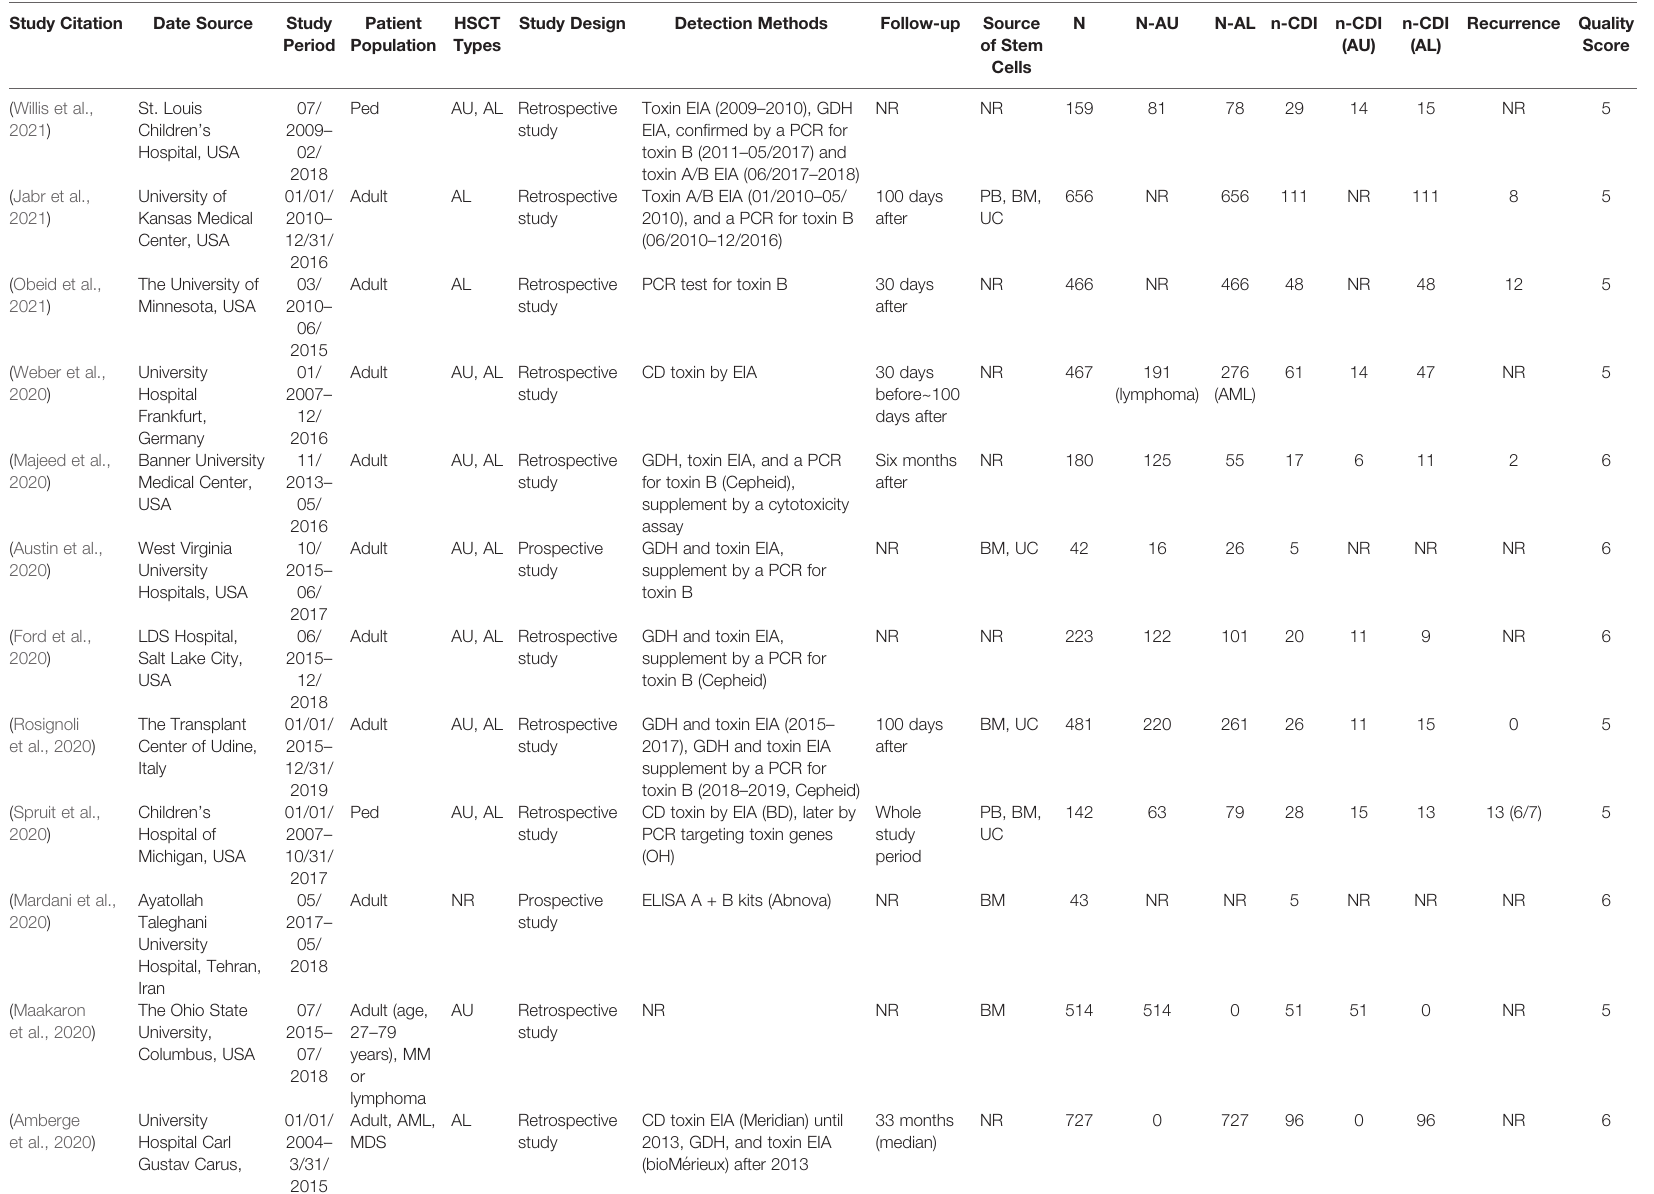
TABLE 1 | Characteristics of eligible